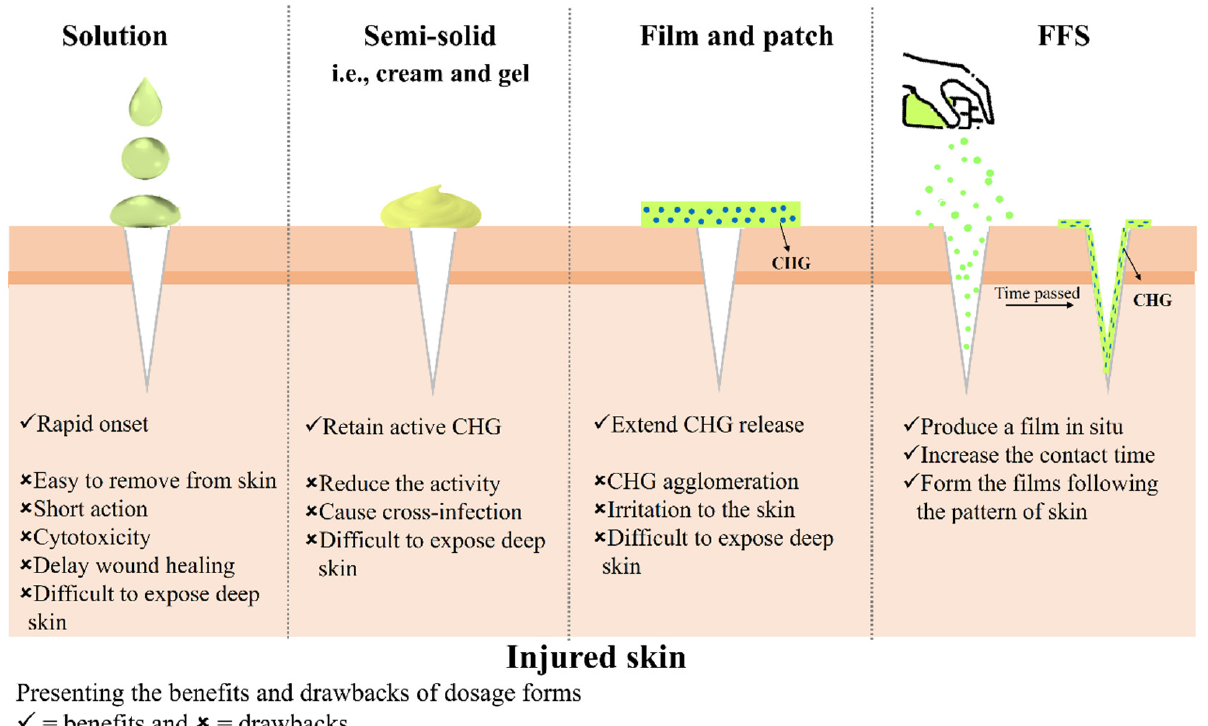
Scheme 1. Mechanism of conventional formulations in comparison to the FFS system presenting the film formation, benefits, and drawbacks of each dosage